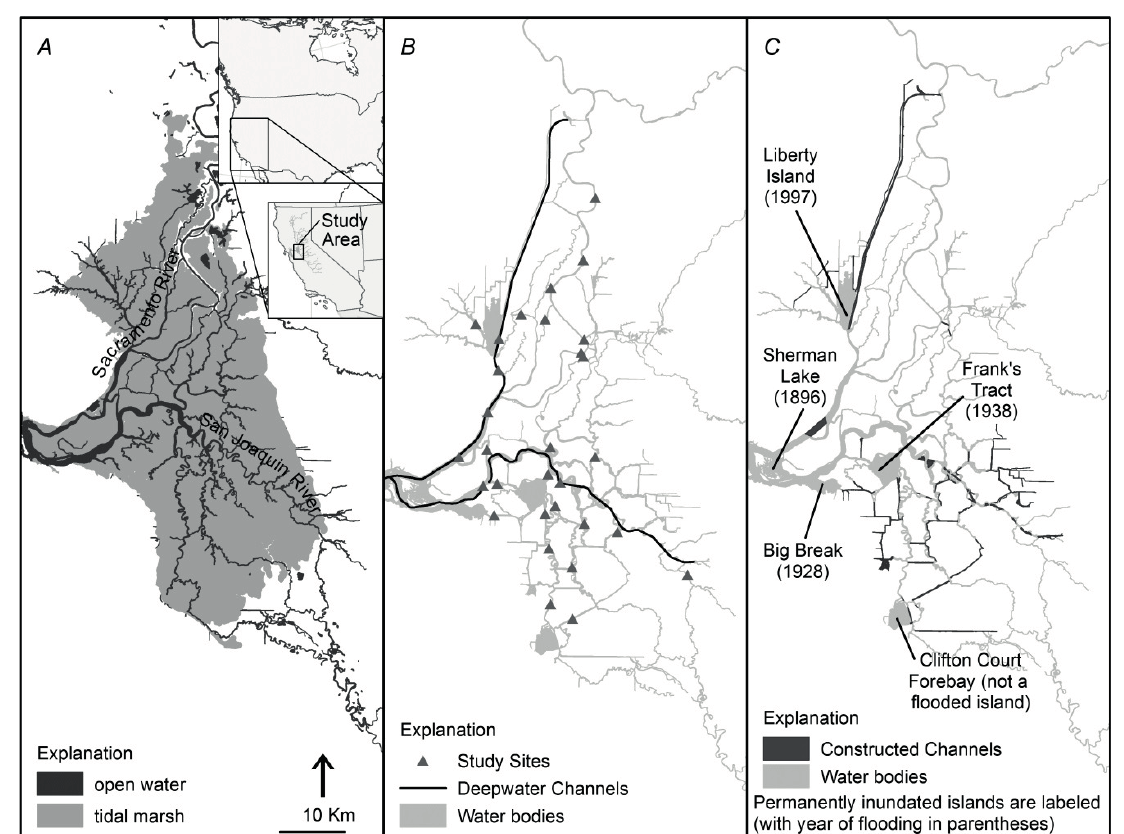
Fig. 1 Maps of study area showing: historical water bodies and tidal marsh (modified from Whipple et al ., 2012) (A); present-day water bodies with deep-water shipping channels and study sites indicated (B); and present-day water bodies with man-made (i.e. constructed) channels indicated